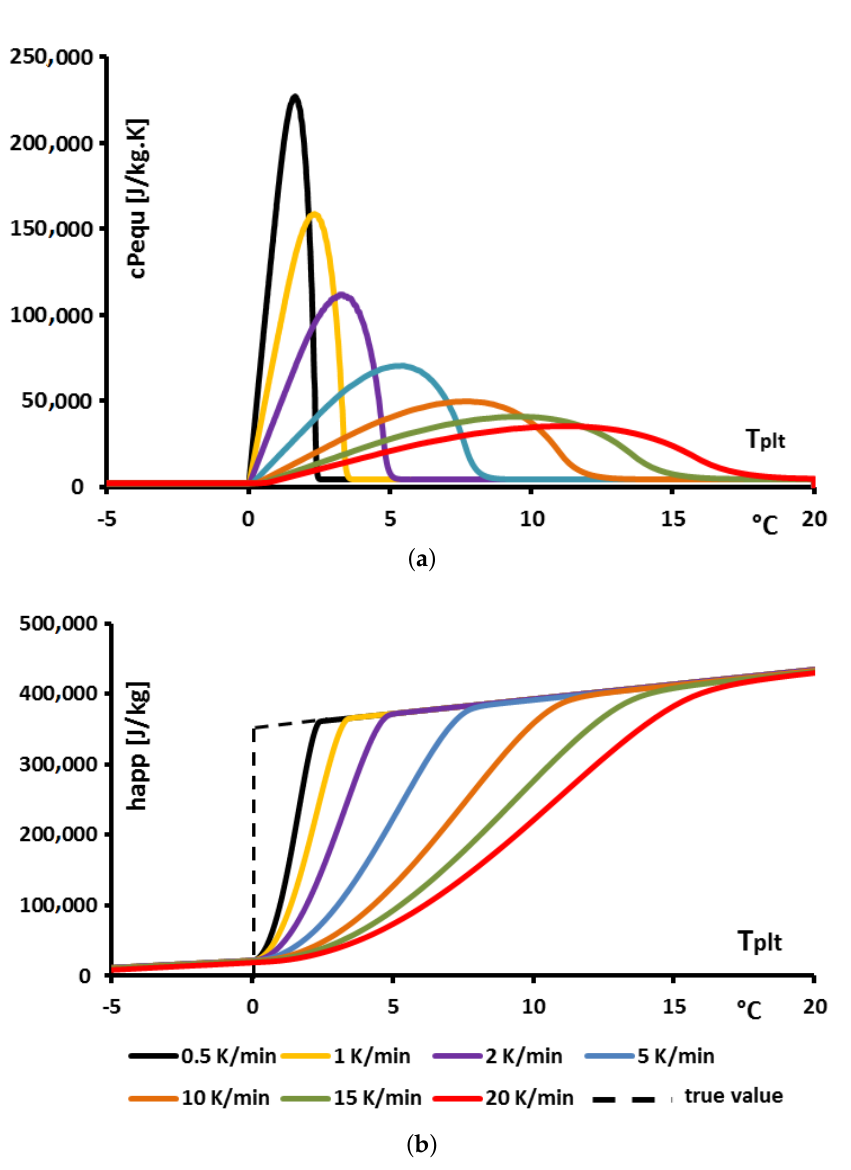
Figure 11. Determination of the enthalpy by the equivalent capacity method. ( a ) Equivalent capacities calculated by Equation (9); ( b ) Enthalpies h app given by an integration of c eq